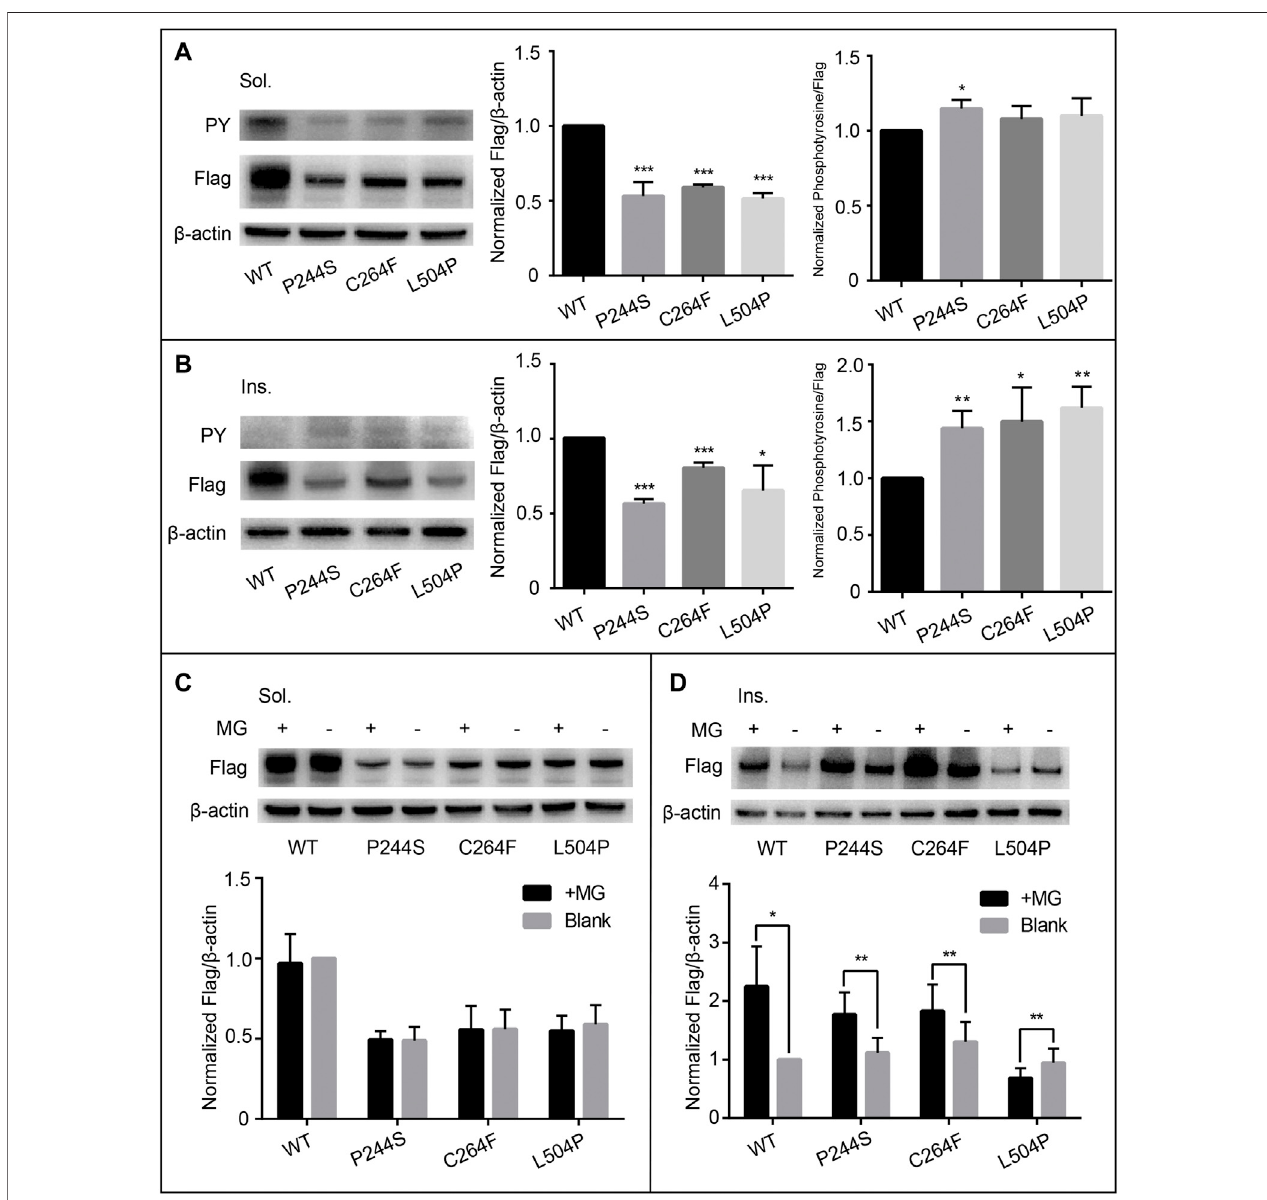
FIGURE 1 | Functional assessment of variants p.P244S, p.C264F, and p.L504P. The expression of soluble protein was signi fi cantly reduced (A) and remained unchanged after MG132 treatment (C) . No dramatic change in auto-phosphorylation was detected (A) . The expression of insoluble protein was also signi fi cantly reduced with increased phosphorylation level (B) . In addition, protein degradation was reversed in p.P244S and p.C264F, while p.L504P was unresponsive to proteasomal inhibition (D) . Sol, soluble; Ins, insoluble; PY, phosphotyrosine; WT, wild type; MG, MG132. ^